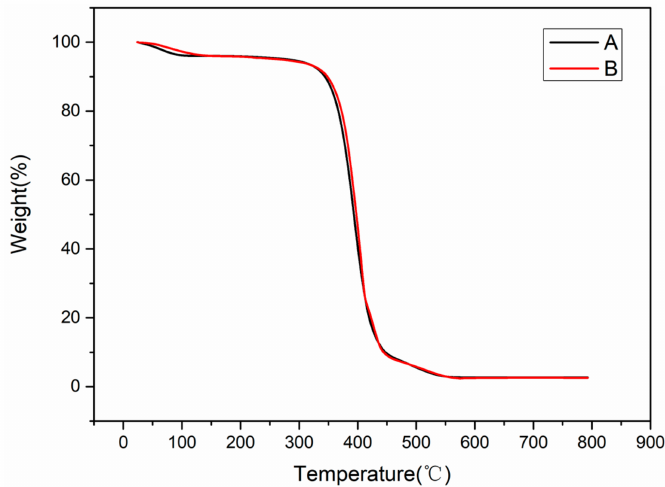
Figure 13. TGA results of the